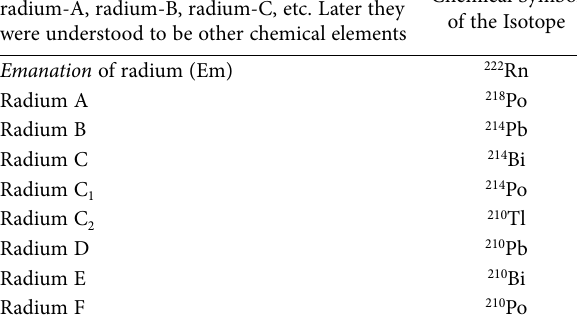
Table 2. The Products of the Decay of